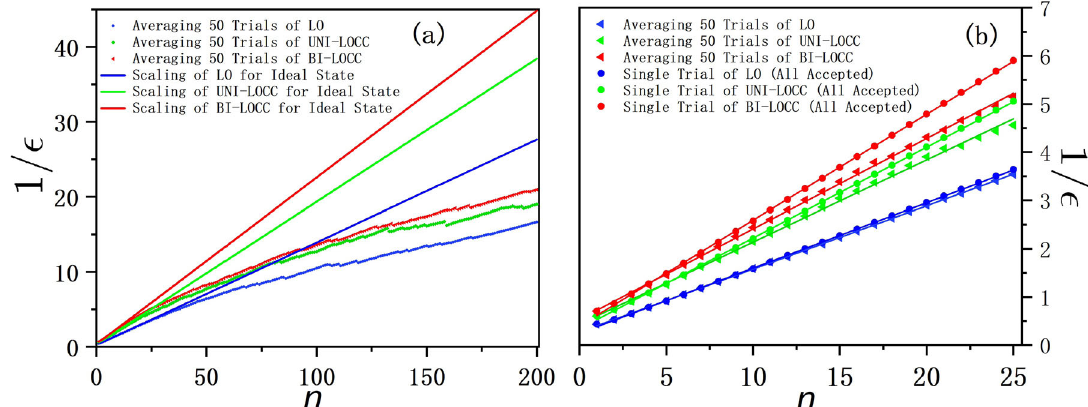
(cid:1) (cid:3) (cid:1) Fig. 3 Experimental QSV of partially entangled state Ψ ð 60 (cid:2) Þ . Three strategies (LO, Uni-LOCC and Bi-LOCC) are utilized in this experiment to verify the entangled state Ψ ð 60 (cid:8) Þj i . For each strategy, a total of 50 trials of QSV are performed, and each trial contains 200 measurements. In both a and b , δ is set to 0.05, and the value of 1/ ϵ is plotted against the number of measurement n . The averaging results of the 50 trials are shown in a together with the theoretical lines for the ideal state. The averaging results suffer from the decoherence and noise of the realistic states and measurements, and thus deviate from the predicted linearity gradually with n . To learn the true performance of the applied strategies, the results of single trials in which all the fi rst 25 measurements output acceptance are shown in b , together with the averaging results of 50 trials in the same range. For each case in b , the data points are linearly fi tted and the performance can be quantitatively characterized by the slope of the fi tting line. The standard deviation for the averaging data points approximately grows linearly with n and is expressed as ε = sn , with s equal to 0.039, 0.052 and 0.049 for the LO, Uni-LOCC and Bi-LOCC strategies, respectively.